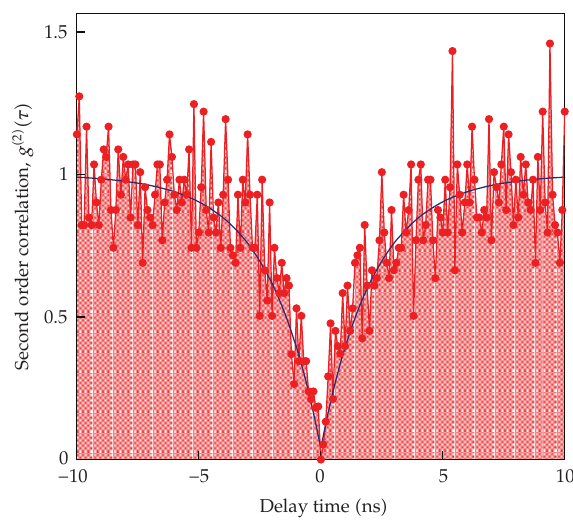
Figure 11: Second-order photon correlation function g (cid:5) 2 (cid:6) (cid:5) τ (cid:6) of single InAs QD embedded in Niobium metal. Blue line is a fitting result with a function g (cid:5) 2 (cid:6) (cid:5) τ (cid:6) (cid:8) 1 − Aexp (cid:5) − B | τ | (cid:6) . Resultant g (cid:5) 2 (cid:6) (cid:5) 0 (cid:6) is as low as 0 . 040 ± 0 . 04, and the time constant B (cid:8) 2 . 17 (cid:5) ns (cid:6) . This indicates that highly suppressed multiphoton emission is possible with the LO-phonon resonant